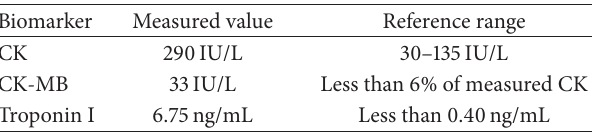
Table 1: Serum cardiac